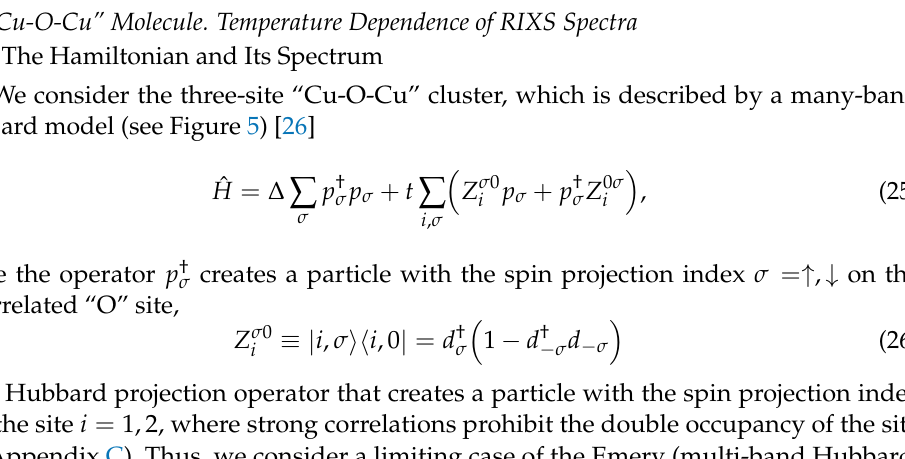
Figure 4. Optical weight W 3 g ( T ) / W 3 g ( 0 ) (23) for various values of the Hamiltonian (9)